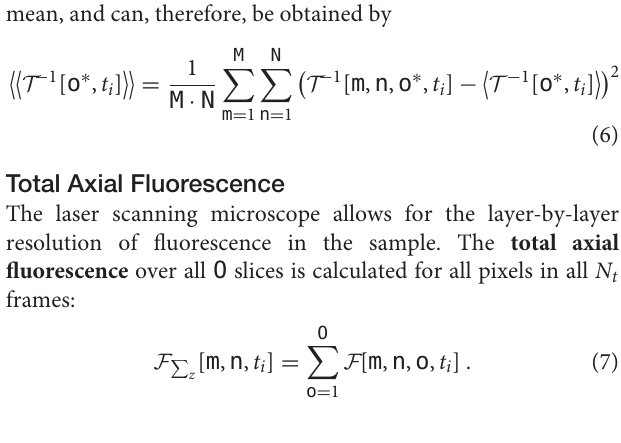
Supplementary Table 1 . The individual image data stacks were merged into one overall image in the LASX acquisition software ( Leica , function: tile merge